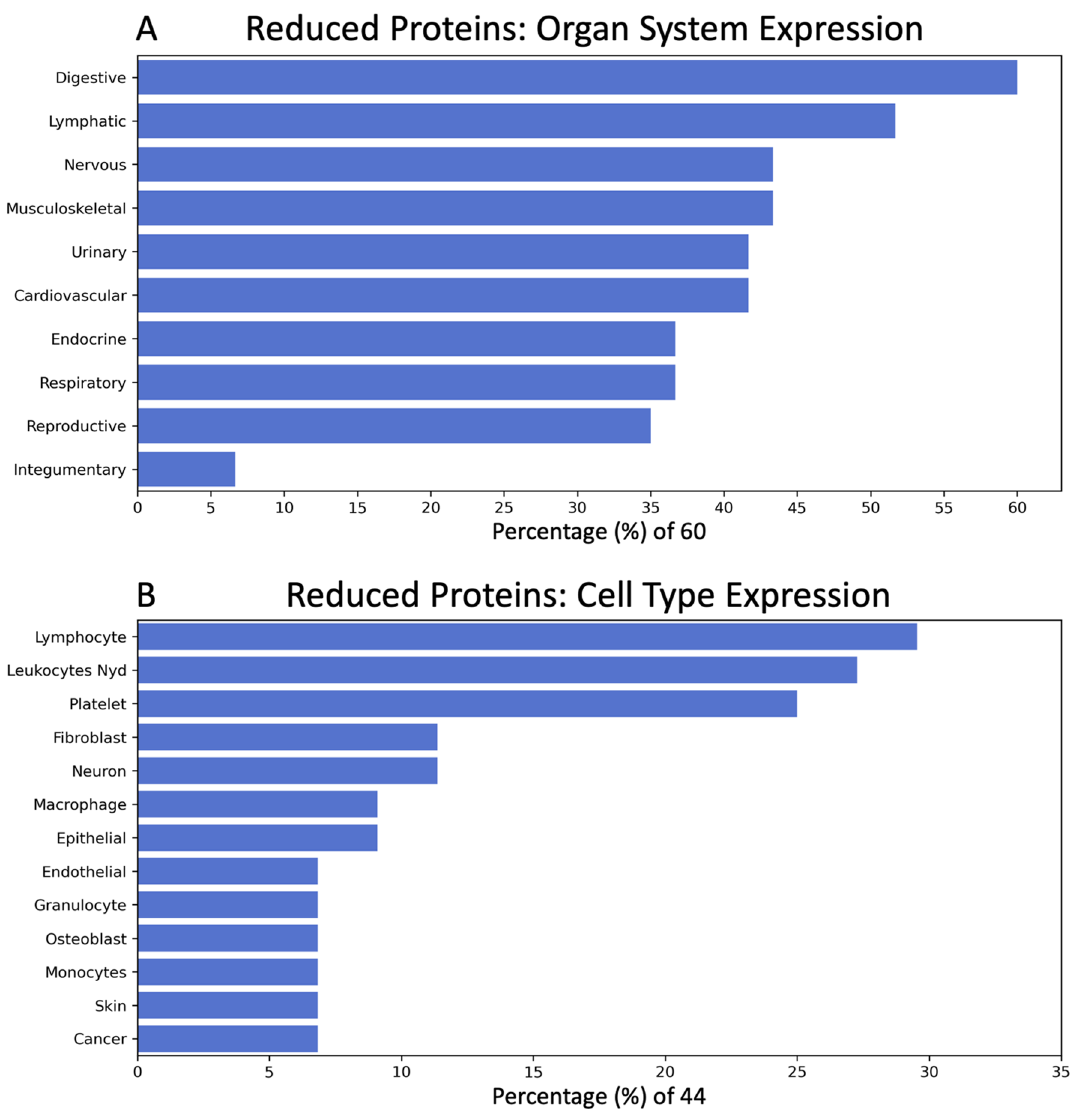
Fig. 3 Frequency of protein expression in major organs/body systems and cell type. A A bar plot demonstrating the percentage of proteins that are expressed in specific major organs and body systems determined by Natural Language Processing. There were total of 60 proteins out of the 119 proteins (50%) with UniProt organ system expression information. The organ system classification combines NLP identified organs, tissue, multi-level tissue and anatomical system entities. B A bar plot demonstrating the percentage of proteins that are expressed in specific cell types determined by Natural Language Processing. There were total of 44 proteins out of the 119 proteins (37%) with UniProt cell type expression information. Only those cell types with percentages greater than 5% are shown for visualization